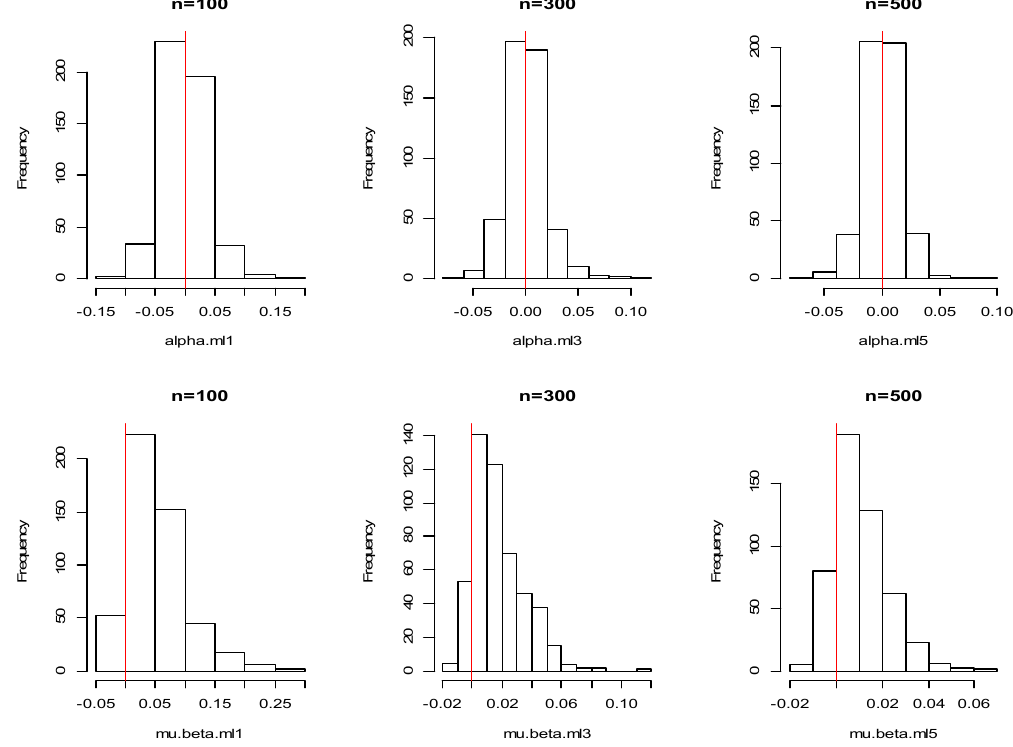
α μ α and µ β with maximum likelihood method in Case and β with maximum likelihood method in Case 4 . Figure 11. Histogram of estimated parameter α μ and β with maximum likelihood method in Case 4 .